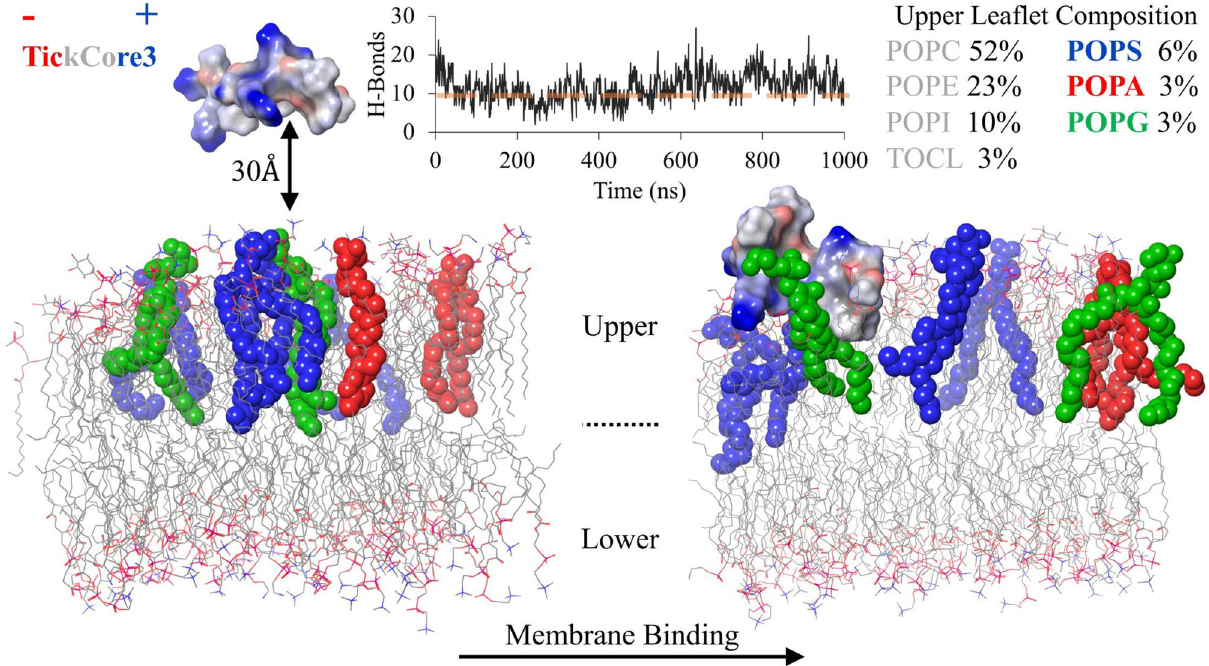
Figure 2. Membrane binding of TickCore3. The TC3 electrostatic potential of its residues are color-labeled as red (negative), grey (neutral) and blue (positive). The TC3 was placed 30 Å—from residue α-carbons to the phospholipid phosphorus atoms of the upper membrane surface. The upper and lower membrane leaflets, before and after 1 μs of MD, are shown with the majority of phospholipids depicted as sticks (grey = carbon, red = oxygen, and blue = nitrogen) (hydrogen atoms not shown). The main phospholipids (POPS, POPA and POPG) forming hydrogen bonds with TC3 are depicted as colored spheres (see legend for color scheme and percent composition). The line graph depicts the number hydrogen bond contacts (H-Bonds; y-axis) throughout the 1 μs of MD (x-axis; in ns). The dashed orange line in the graph is the average H-Bond contacts ( x = 9.7 ) between the membrane and the